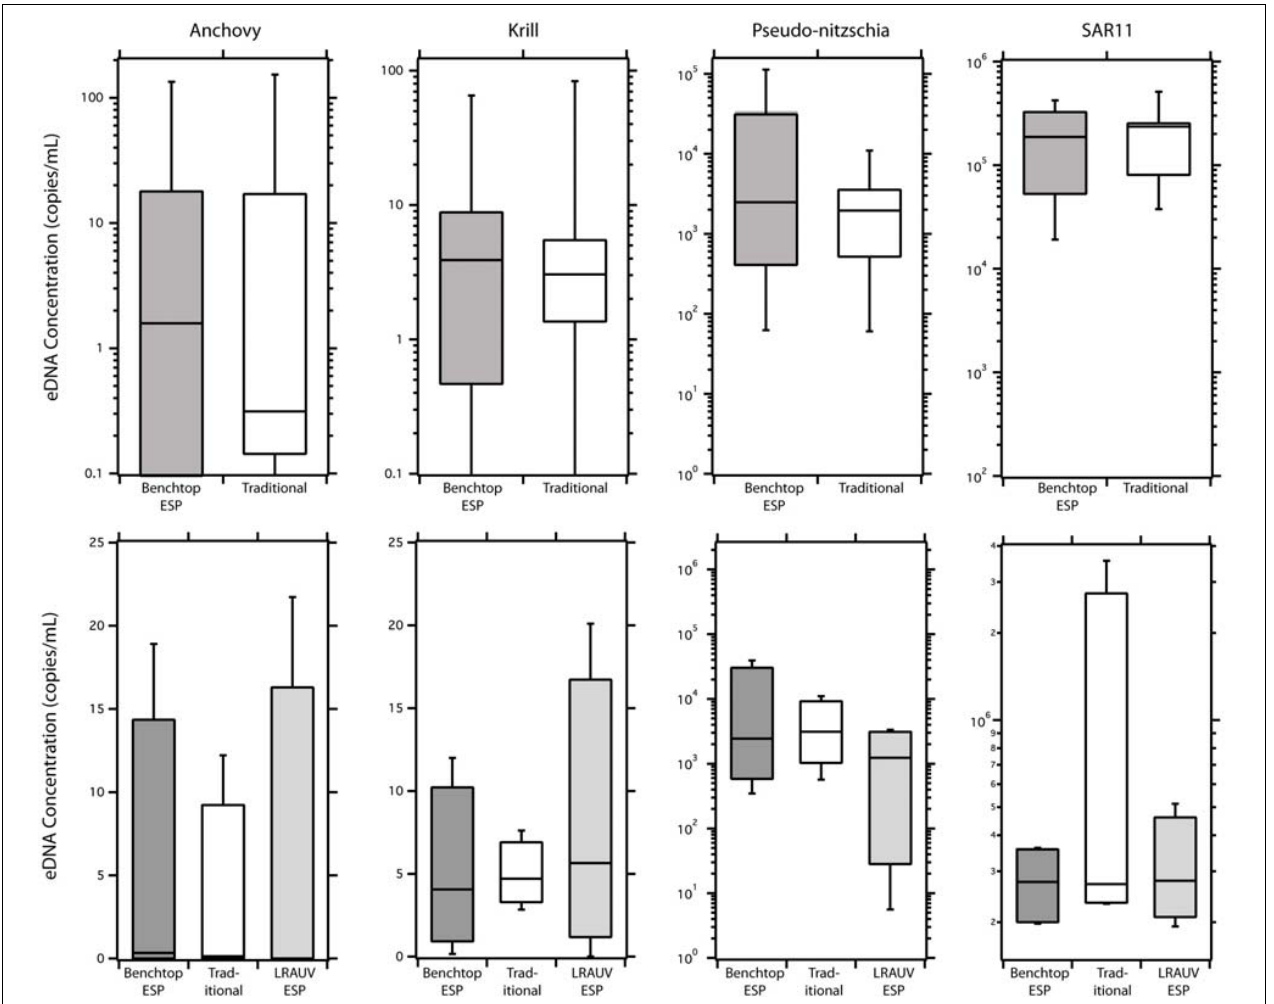
FIGURE 3 | eDNA recovery comparisons between ESP (dark gray bars) and traditional peristaltic (white bar) methods. Direct comparisons (top panel) between benchtop-ESP and traditional peristaltic methods where samples were collected from the same sample bottle. Collection method comparisons (bottom panel) between in situ collected and preserved LRAUV-ESP (ESP onboard LRAUV) samples (light gray) collected in close proximity to ship-based method utilizing a CTD Rosette with Niskin bottles. Niskin bottle samples were processed using both a benchtop-ESP (dark gray) and the traditional peristaltic method (white). Error bars represent 95% confidence